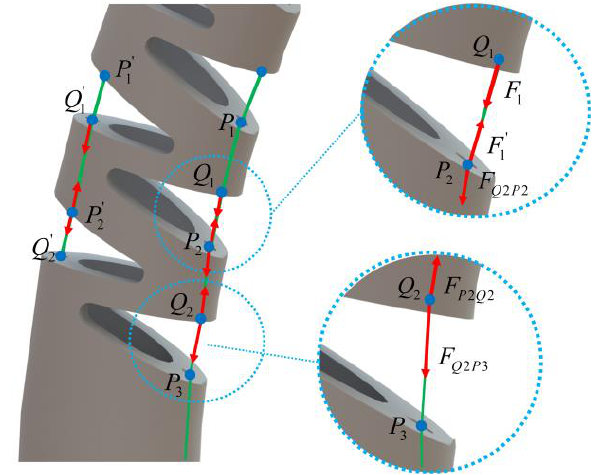
Figure 3. A model of a single